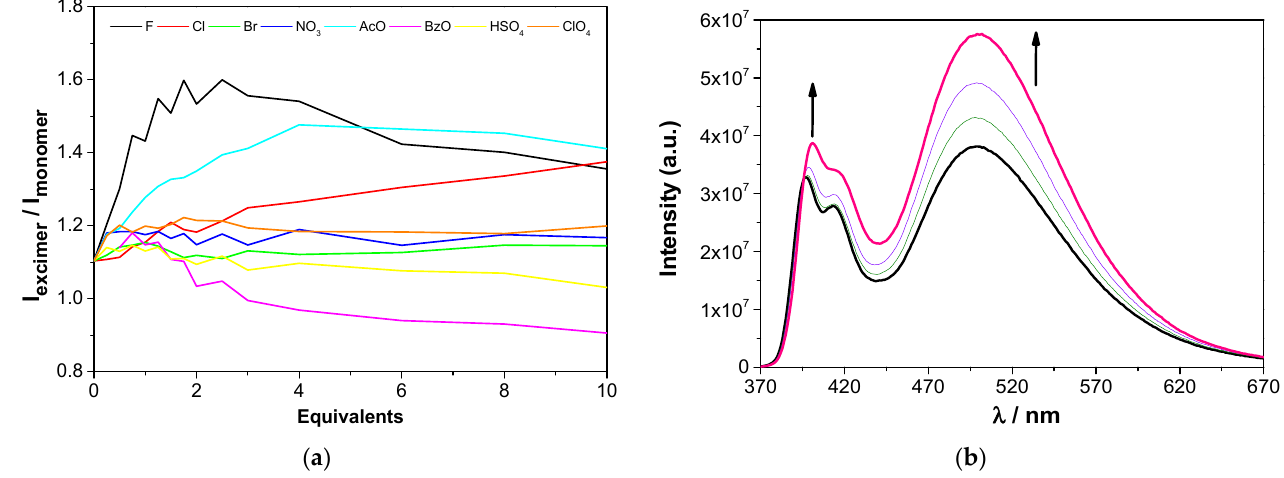
Figure 6. ( a ) Ratio of excimer and monomer peak intensities of urea 4c upon addition of TBA salts, ( b ) Changes in the emission spectrum of urea 4c upon addition of 0 (black), 0.75 (olive), 2 (violet) and 10 equiv. (pink) of TBA AcO. The arrows indicate the increasing amounts of salt. [ 4c ] = 1.0 × 10 − 5 M in CH 2 Cl 2 . Table 3. Association constants (log K ass ) a of (thio)ureas 4a – 4c determined by UV–Vis absorption and emission at 25 °C.